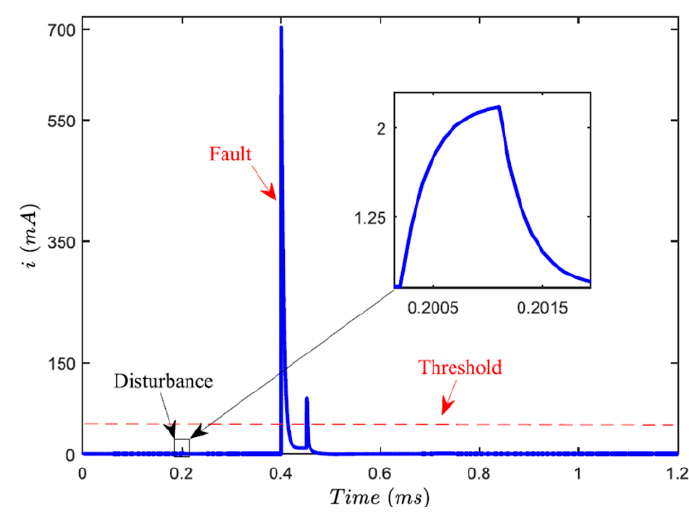
Figure 17. Non-zero residual current of the C 1 for disturbance and fault occurrence.